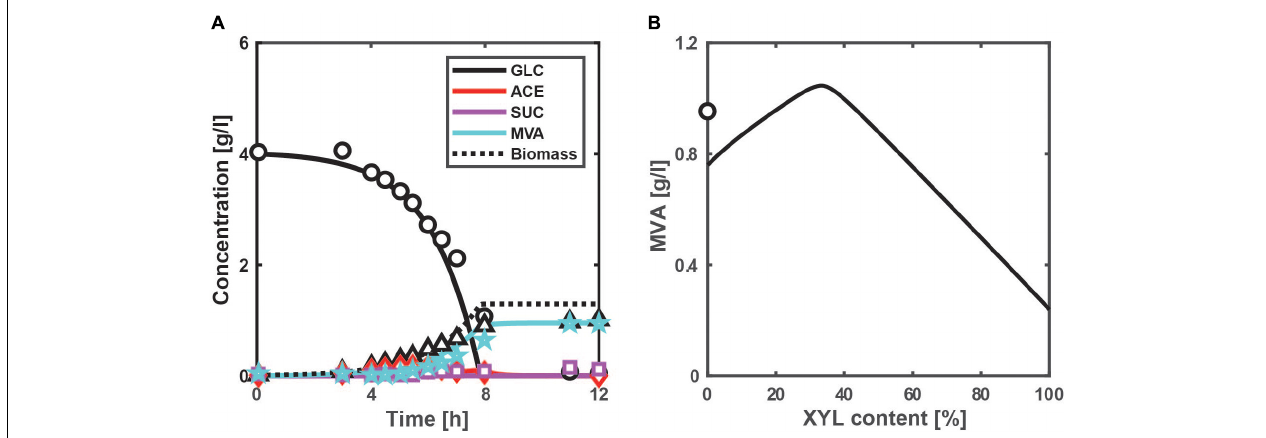
FIGURE 5 | Simulation results of the batch cultivations of the MVA-producing strain under aerobic condition. (A) Time-course profile of the extracellular metabolites and biomass concentrations for the case of using glucose, where the lines show simulation results and the symbols represent experimental data (Wada et al., 2017), where an MVA-producing E. coli strain was constructed by introducing MVA pathway genes. (B) The simulated final MVA concentrations of the pgi mutant with the overexpression of ArcA (TF ArcA = 0.95) for the cases of using a mixture of glucose and xylose. The xylose content [%] is defined as the ratio of xylose contained in a mixture. The total substrate concentration is 4 g/l. The symbol shows the experimental data of (A) (Wada et al.,